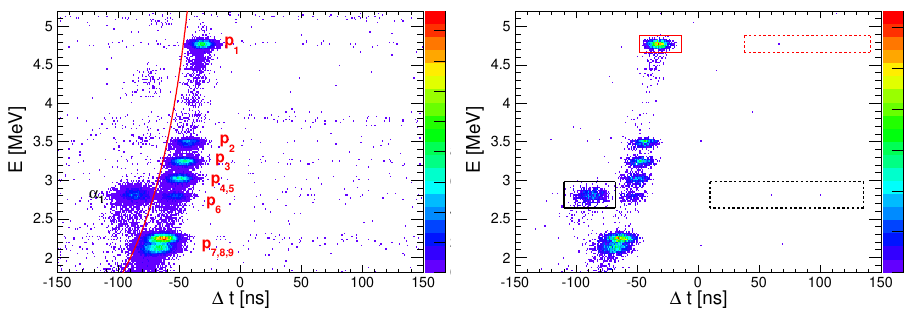
Figure 1. Correlation of charged particle energies with the gamma-particle time-di ff erence. (Left) Evaporation particles with gamma coincidences populating the i -th excited states for 12 C + 12 C → 20 Ne ∗ + α 12 C + 12 C → 23 Na ∗ + p i are indicated in black and for i in red. (Right) The event selection gates for observations (solid boxes) and background events (dashed boxes) are displayed for the α 1 and p 1 transition, after selection of the associated gamma